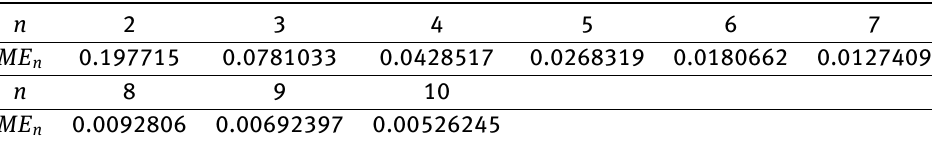
Table 4: The maximal error parameter ME n .